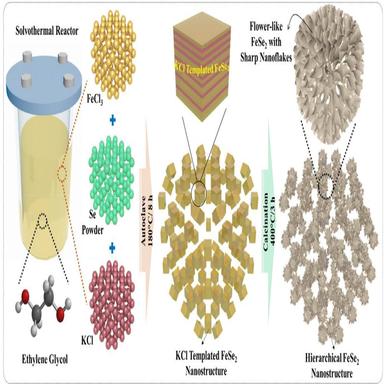
Schematic illustration presenting the preparation of hierarchical flower-like FS nanostructure using a KCl-templated solvothermal technique and a calcination process.